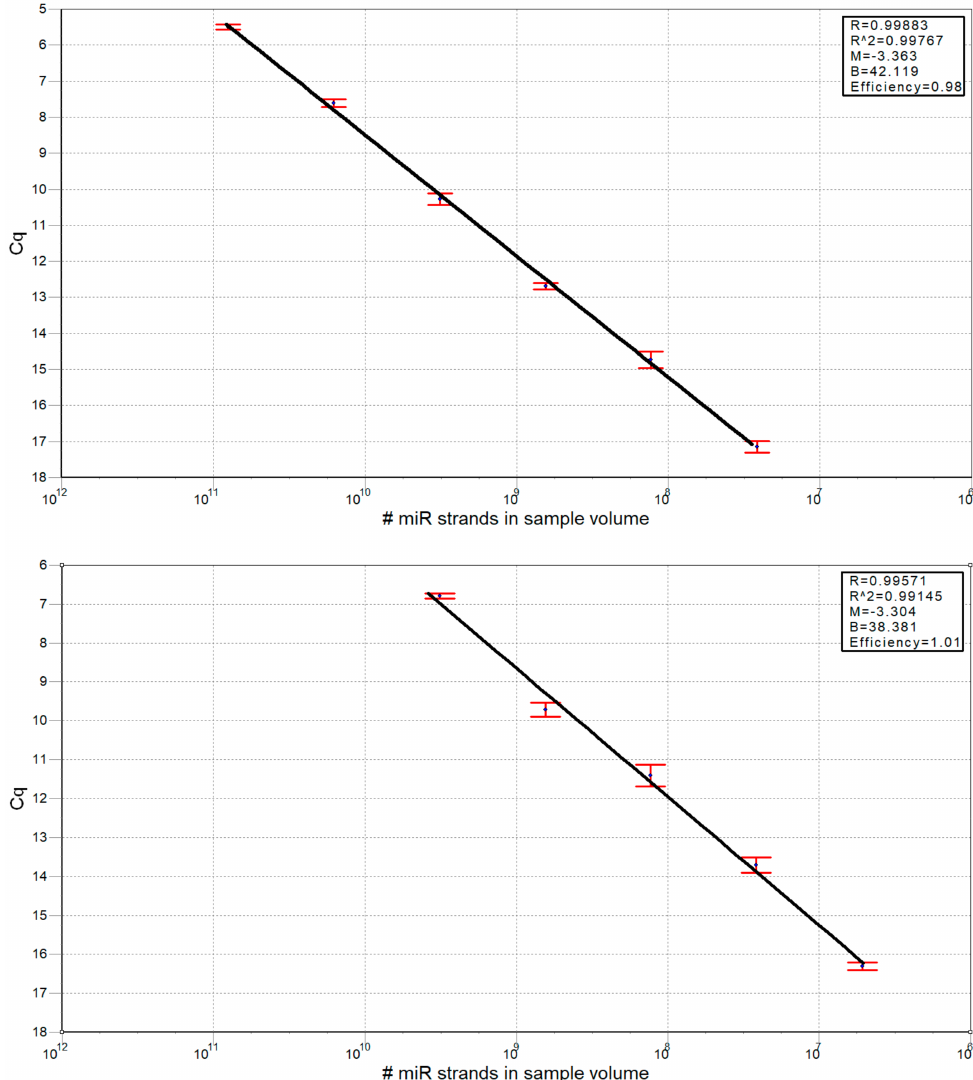
Figure A2. Standard curves for miR-145 (top), miR-155 (center) and miR-223